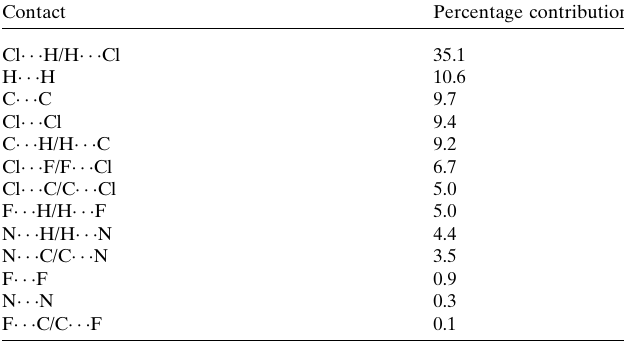
Table 3 Percentage contributions of interatomic contacts to the Hirshfeld surface for the title compound..